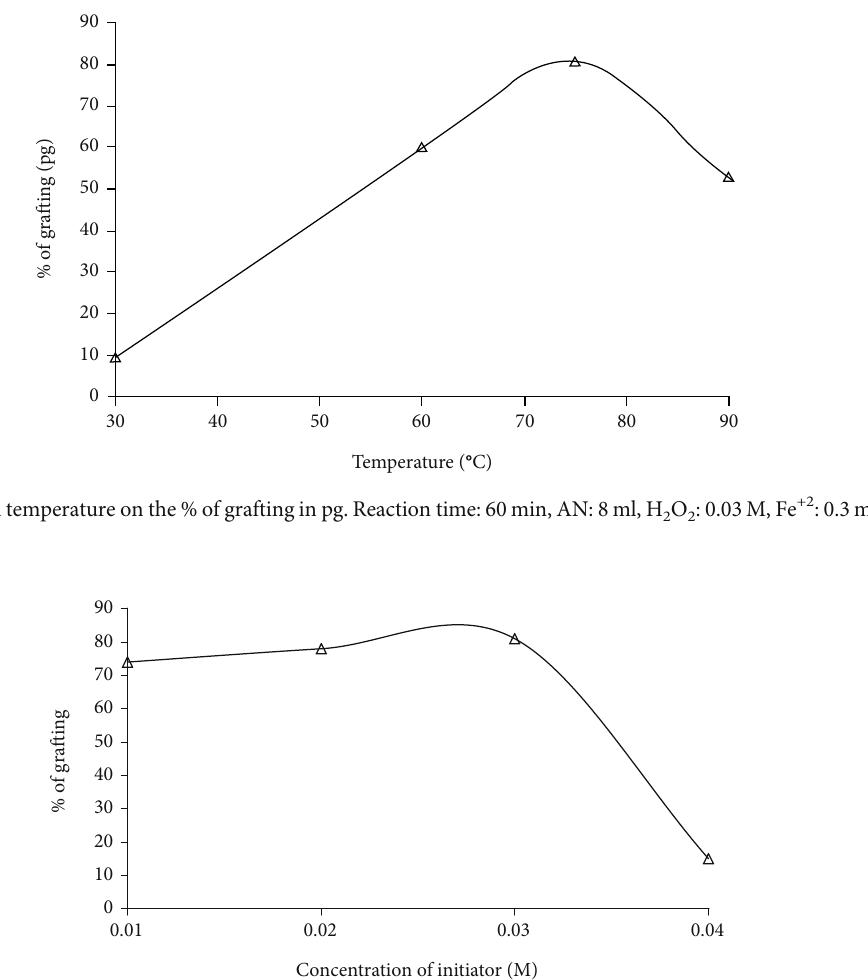
O on the % of grafting. Reaction time: 60min, AN: 8ml, temperature: 75 ° C, Fe +2 : 0.3mmol, and 2 2